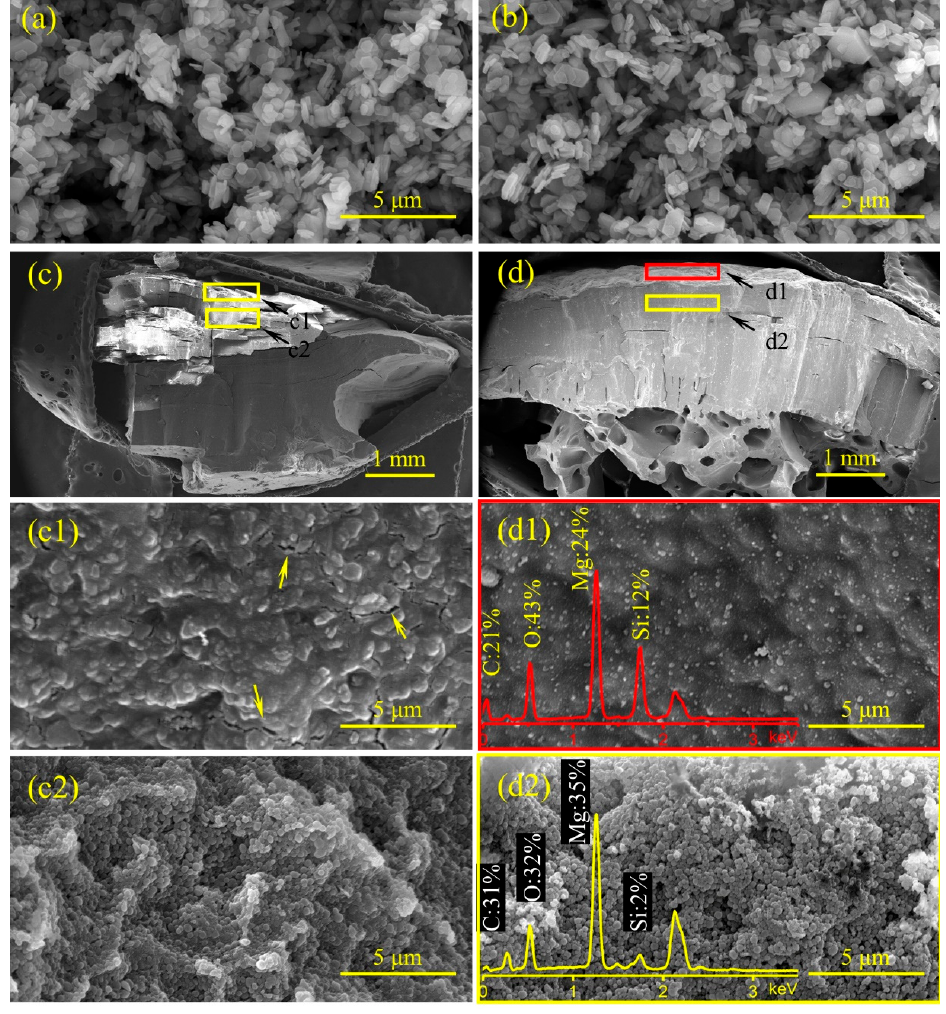
Figure 9. SEM micrographs of MH ( a ), MgO ( b ), the residual char of EVA/MH 50/50 ( c , c1 , c2 ), and EVA/MH/PCS 50/48/2 ( d , d1 , d2 ) after the CONE test: the cross-section at 60× magnification ( c , d ), the surface ( c1 , d1 ), and the cross-section at 20,000× magnification ( c2 , d2 ); the EDS spectra were embedded in the corresponding SEM micrographs. The silicon atomic percentage along the thickness direction was analyzed by EDS.